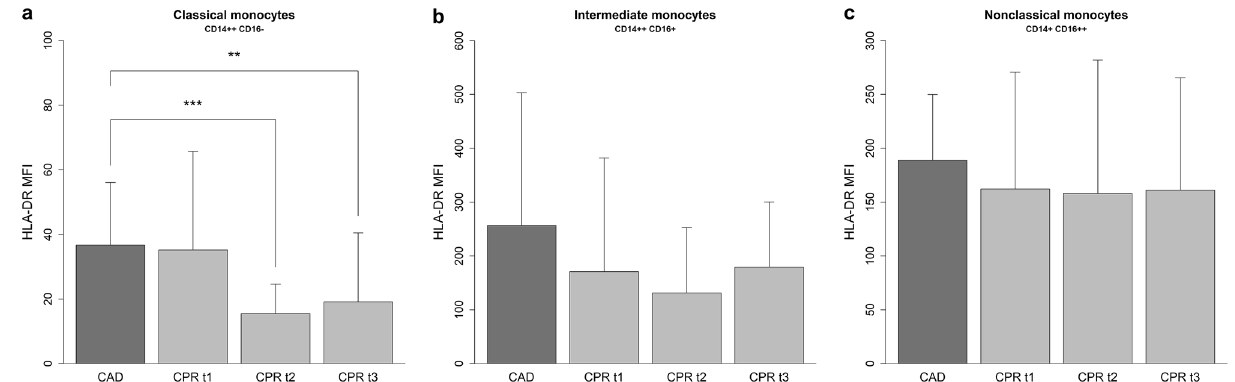
Figure 3. HLA-DR expression on monocyte subpopulations in resuscitated patients and the control group. HLA-DR surface expression levels on monocyte subpopulations of patients from the CPR group in the first 12 h (CPR t1: n = 22), after 24 h (CPR t2: n = 21), and 48 h (CPR t3: n = 16) following cardiac arrest, as well as of patients from the control group (CAD: n = 19) are shown. Statistical hypothesis testing was performed using